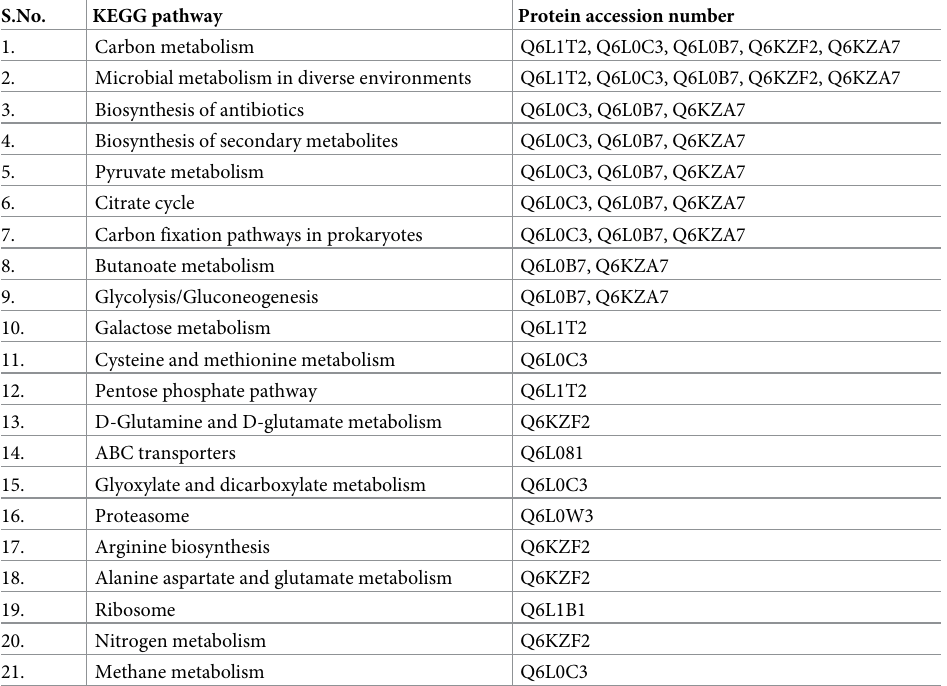
Table 3. Details of P . torridus secretory proteins involved in the various KEGG pathways.